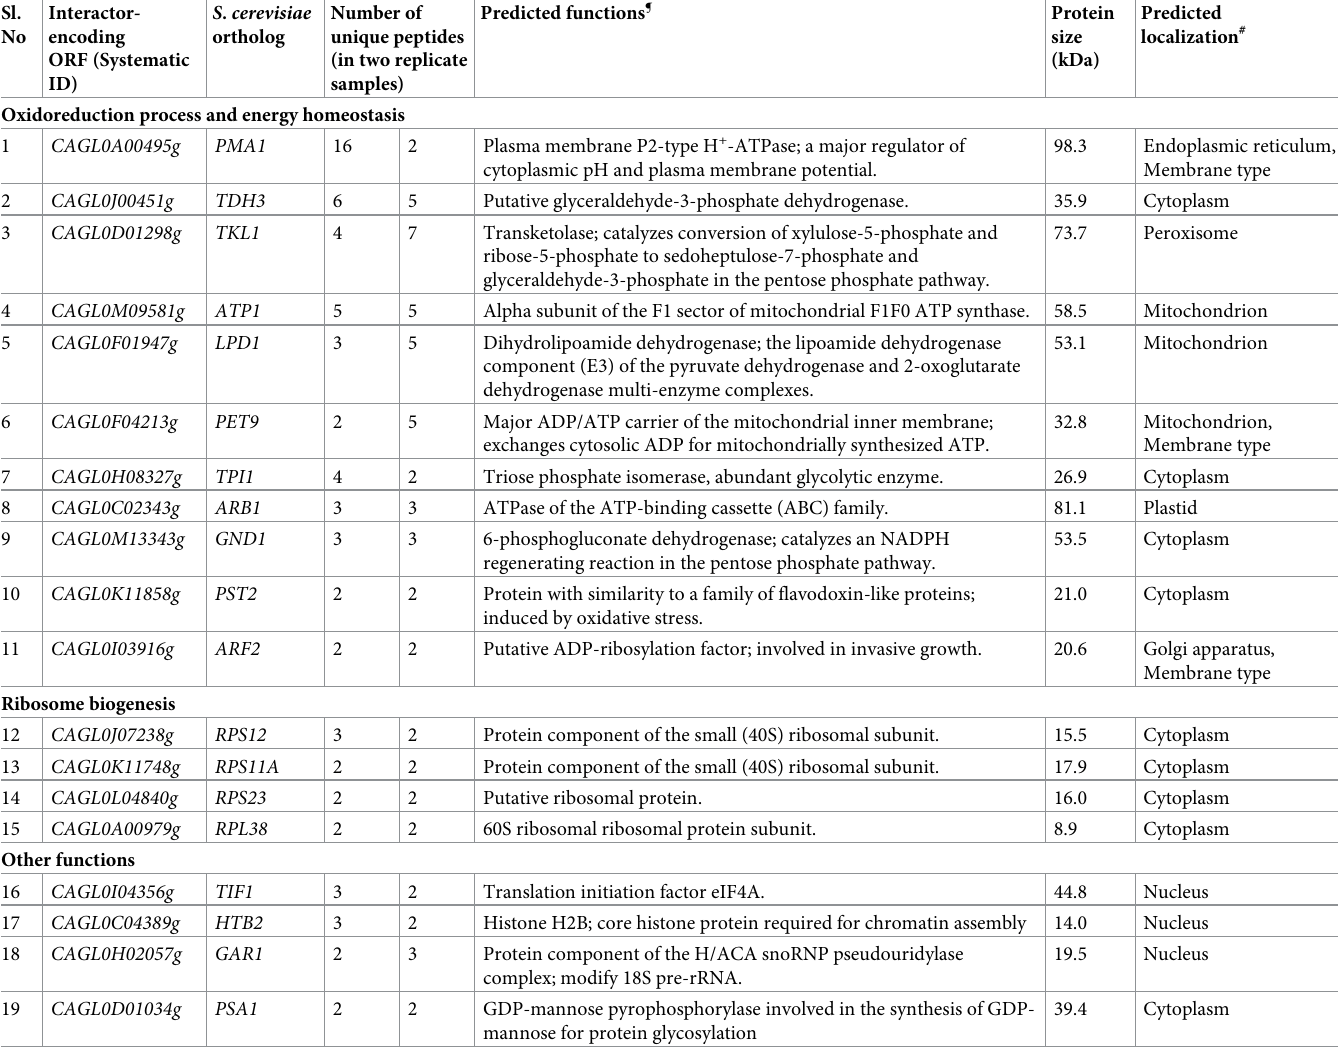
Table 1. List of CgYps1 interacting proteins, as identified by immunoprecipitation-mass spectrometry analysis. Sl. Interactor- No encoding ORF (Systematic